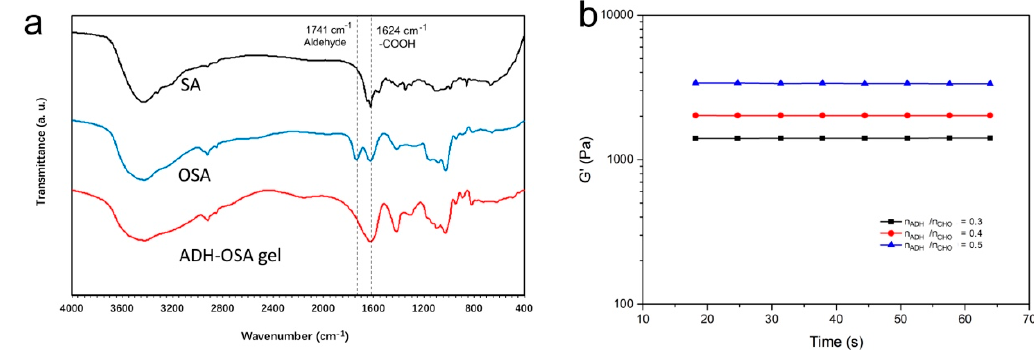
Figure 2. ( a ) The FTIR spectra of sodium alginate (SA), oxidized sodium alginate (OSA), and ADH- OSA gel. ( b ) The storage modulus of tetramycin-loaded gel with different linker amounts. n ADH and n CHO are the molar quantity of adipic dihydrazide (ADH) and total CHO group in the gel, respectively.